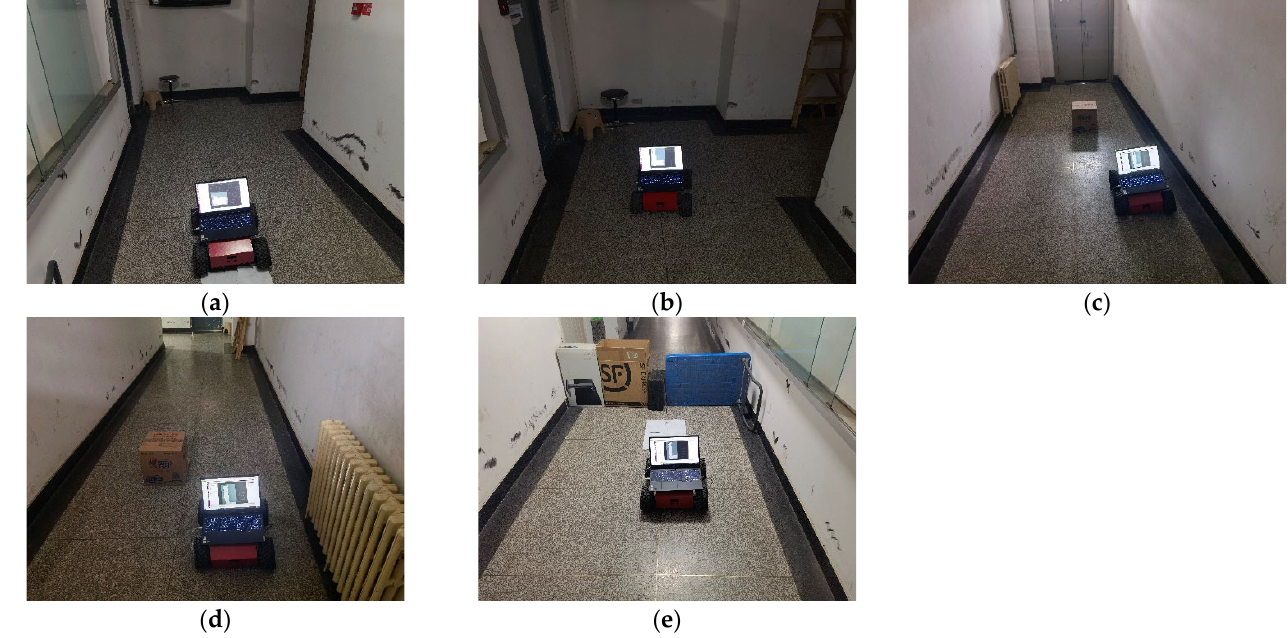
Figure 20. Mapping experiment. ( a ) Start mapping; ( b ) Turn right; ( c ) Avoid the carton; ( d ) Bypass the carton; ( e ) Back to the start point.